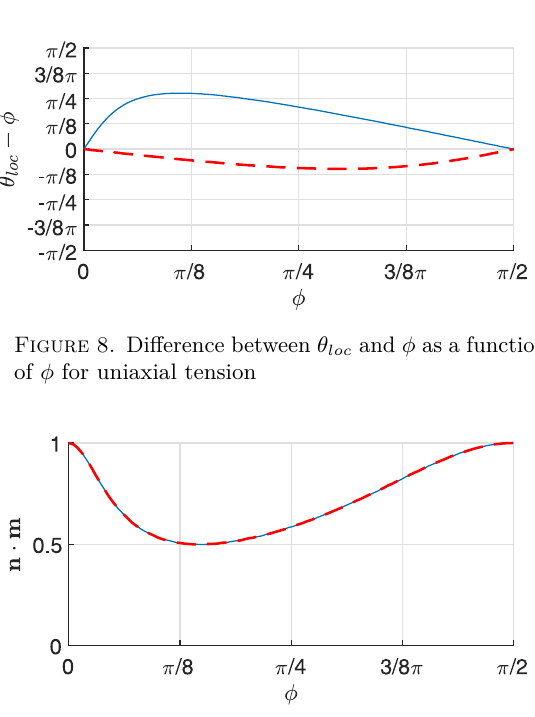
Figure 7. Dependence of θ loc on φ for uniaxial tension